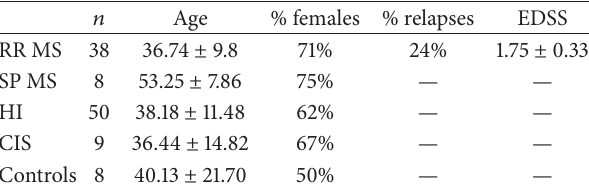
Table 1: Summary of patients and sample